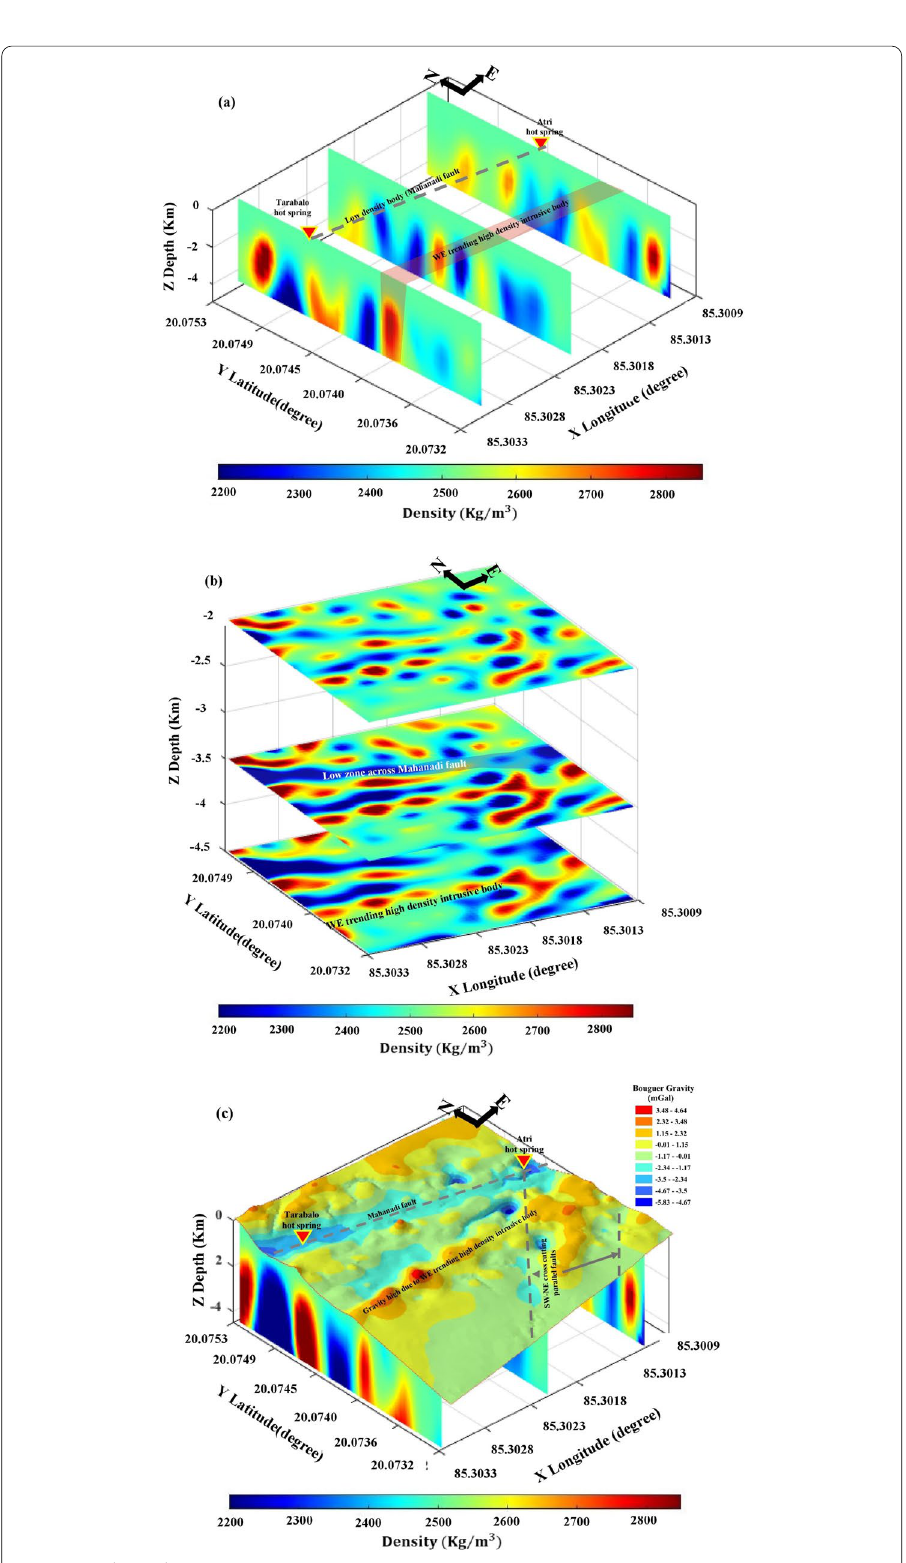
Fig. 9 (See legend on previous